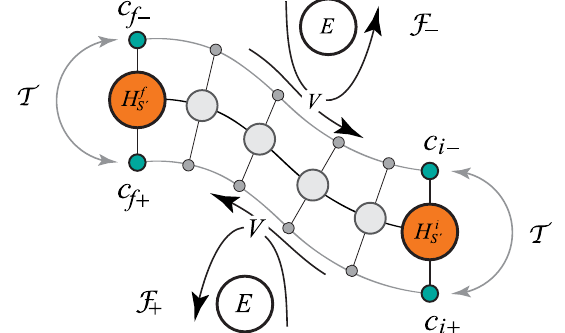
FIG. 3. A quantum Crooks relation. Derivations of fluctuation relations often rely on time reversals and time-reversal symmetry in some form [3 – 6,8 – 10]. In our case, time-reversal symmetry enables us to, in effect, let the evolution run “ backwards ” by swapping the control states from a “ forward track ” to a “ reverse track. ” By this method, we amend for the overambitious global reversal of the evolution that we employed for the intermediate fluctuation relation and obtain a quantum counterpart to the reversal of the control parameter in the classical Crooks relation. Analogous to the setup in Fig. 2, the initial control state j c i þ i yields an evolution where the initial Hamiltonian H i is trans- S 0 formed to the final Hamiltonian H f when the control state j c f þ i S 0 is reached. This process induces a channel F on the energy þ reservoir E . For each of these control states, there exists a time- reversed partner starting with j c and ending with j c , thus f − i i − i bringing the Hamiltonian H f back to H i . This process induces a S 0 S 0 channel F − on the reservoir. By assuming time-reversal sym- metry, the channels F and F − can be related via the quantum þ Crooks relation in Eq.